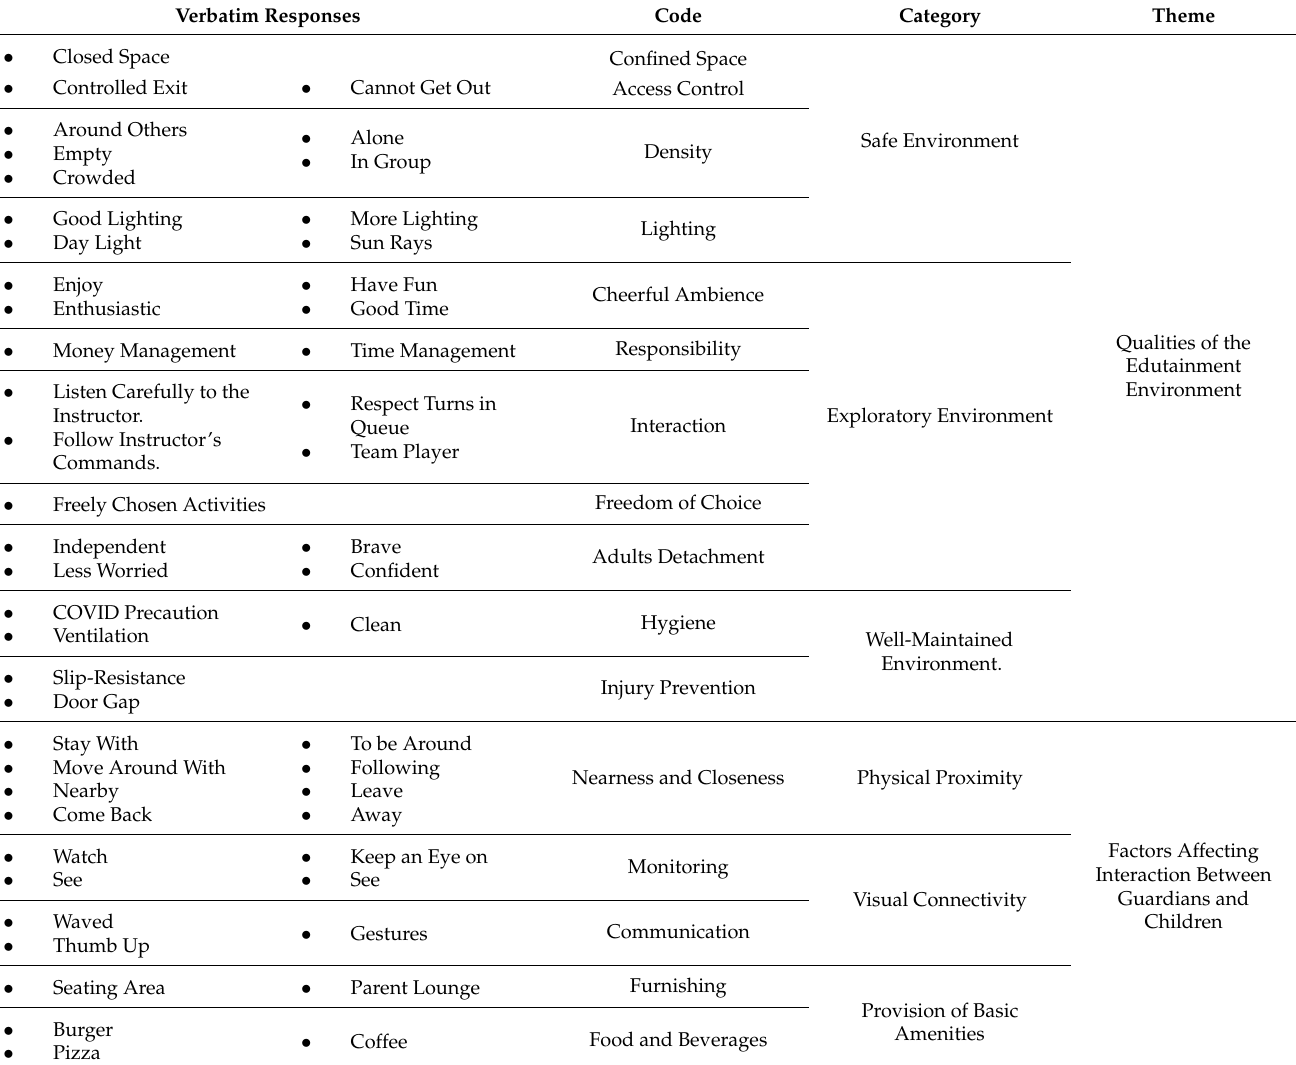
Table 2. The identified codes, the associated main categories, and the extracted